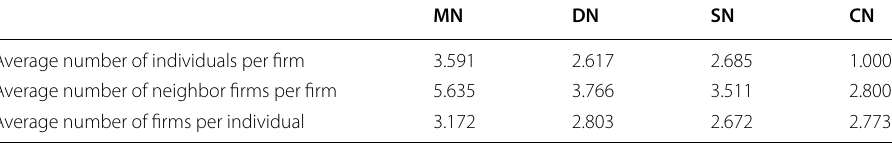
Table 9 Descriptive statistics of different interfirm